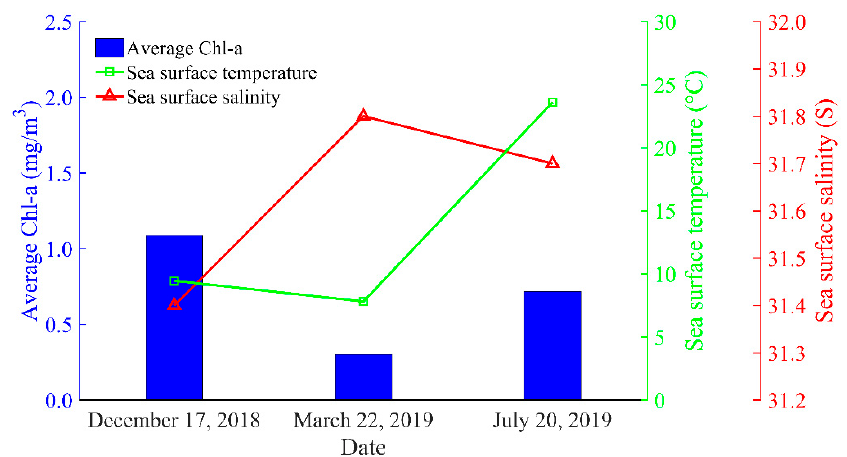
Figure 11. The temporal variations of average Chl-a concentration, sea surface temperature (SST), and sea surface salinity (SSS), and the relationship between them.